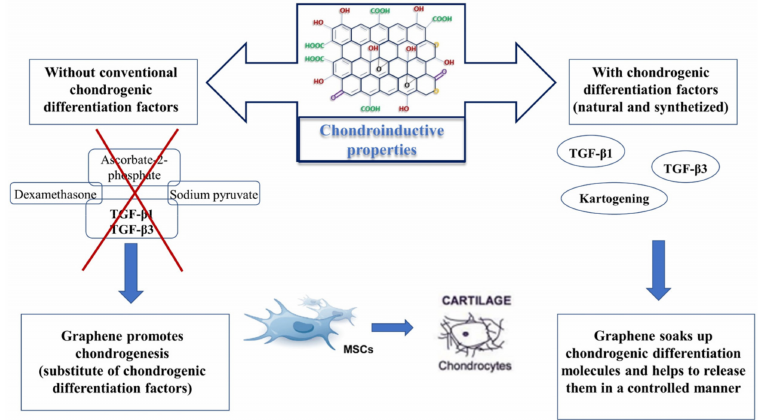
Figure 5. Chondroinductive properties of GO. Graphene oxide promotes chondrogenesis without the addition of conventional chondrogenic differentiation factors in growth media. In parallel, it can enhance chondrogenesis, thus helping to release differentiation factors from biomaterials in a controlled manner. TGF- β 1 = transforming growth factor beta 1; TGF- β 3 = transforming growth factor beta 3; MSCs = mesenchymal stem cells.